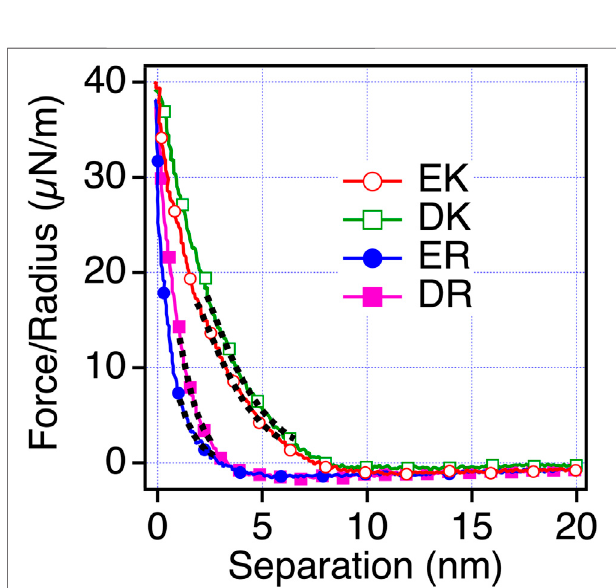
FIGURE 4 | Force-separation curves recorded on an approach for the symmetric system of the peptide-SAMs (the same SAMs formed on both probe and substrate) in PBS solution. The fi tting results are shown with black dotted